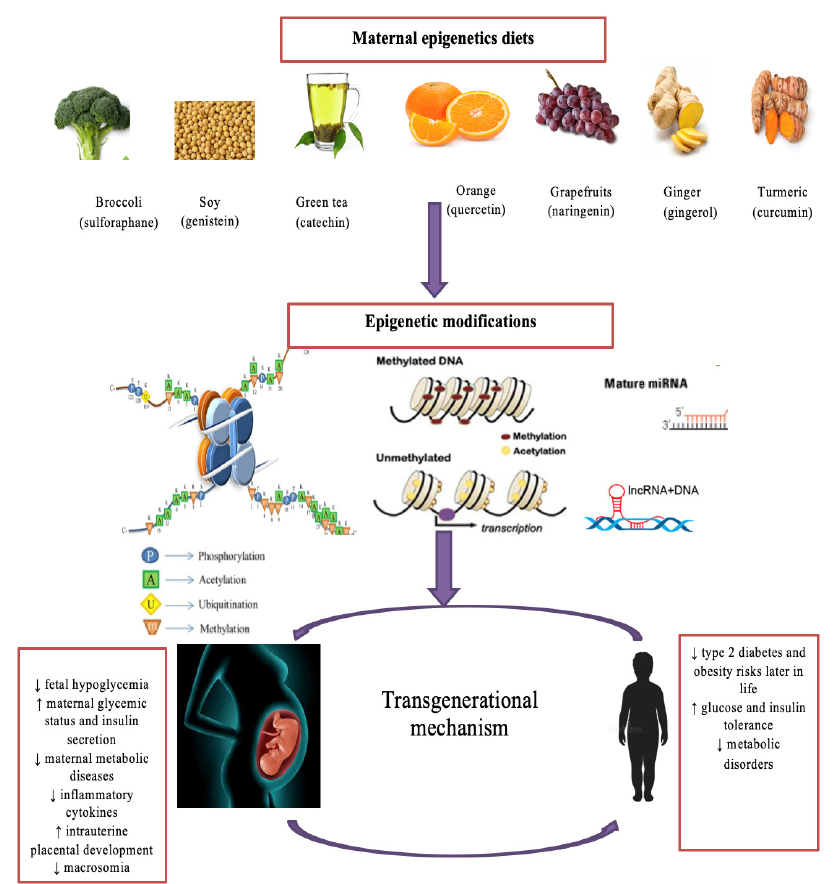
Figure 2. The impact of bioactive epigenetic dietary compounds on GDM. Maternal consumption of bioactive dietary components from a variety of epigenetics diets, such as sulforaphane in broccoli, genistein in soy, and catechins in green tea, can mediate epigenetic changes, such as histone modi- fications, DNA methylation patterns, and non-coding RNAs. Consequently, these epigenetic changes prevent metabolic disorders in GDM mothers, their developing fetuses, and their offspring later in life. Lastly, chromatin changes that influence metabolic disease susceptibility can be trans- ferred from one generation to the next generation through epigenetic inherence from maternal epi- genetics diets. miRNA refers to microRNA and lncRNA refers to long non-coding RNA. ↑ refers increase and ↓ refers decrease.